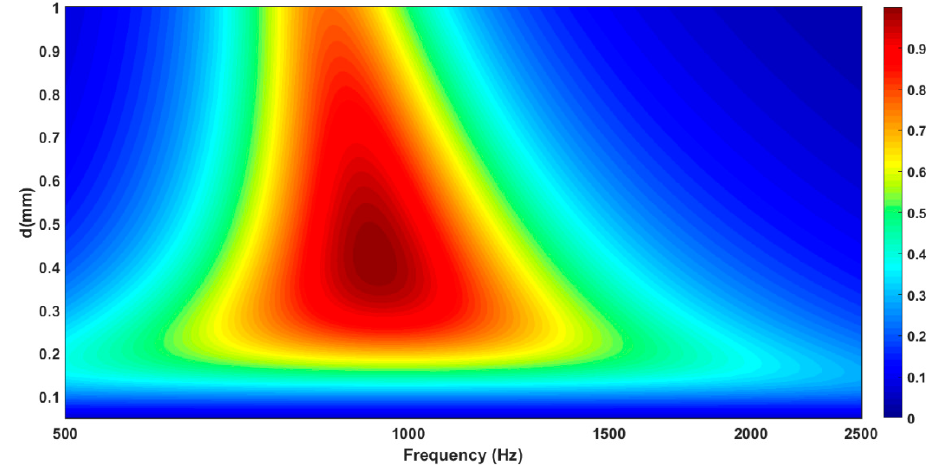
Figure 6. Absorption coefficient of an SL-MPP as a function of ( f , d ) for ( t , φ , D ) = (1 mm,1%,2 cm).